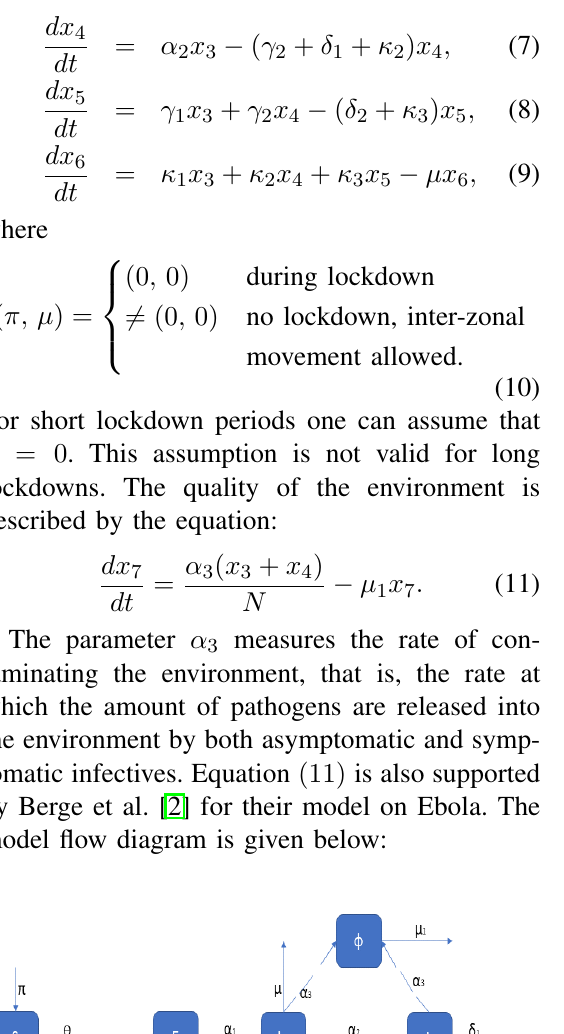
Fig. 4: Model flow diagram N